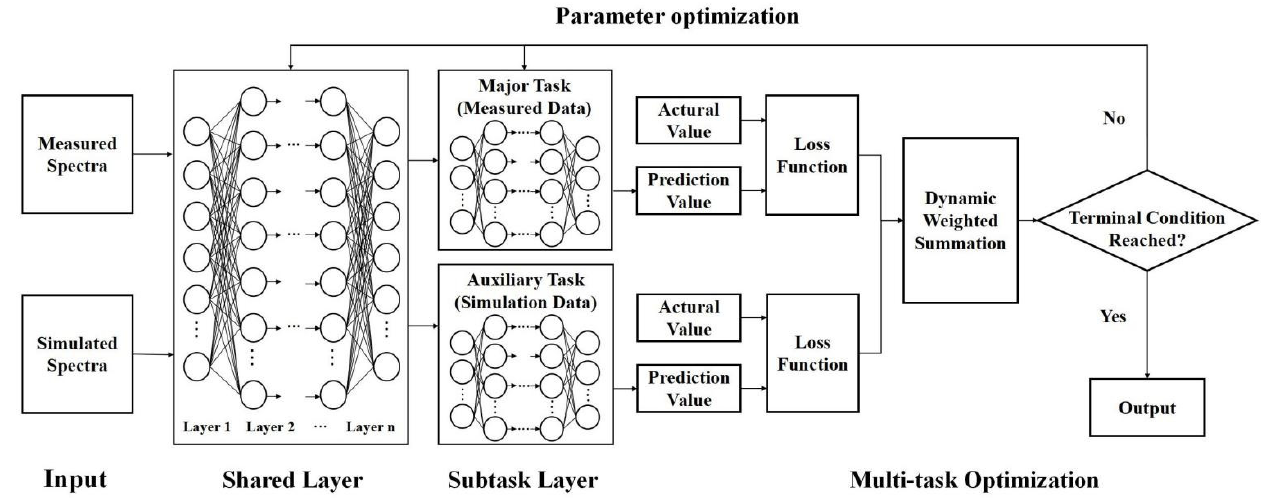
Figure 2. Main structure of the proposed model.